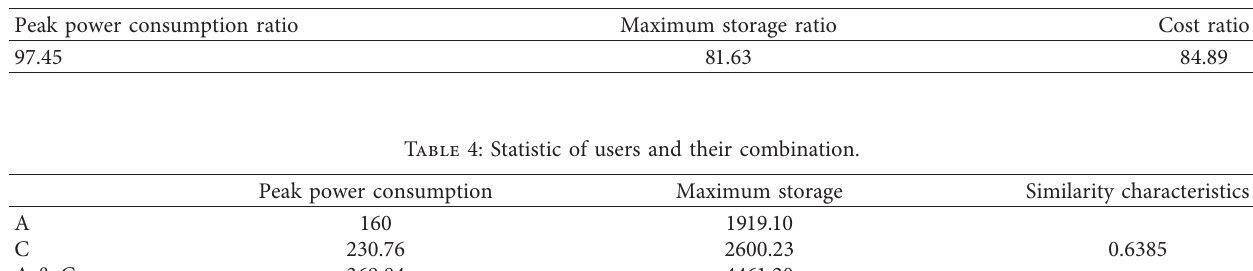
Table 3: Ratio of the statistic of users and their combination.